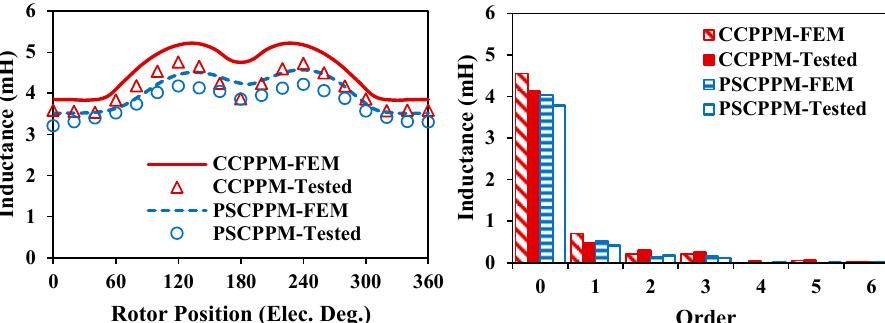
Figure 40. Inductance waveforms and spectra of 12s8p machines.